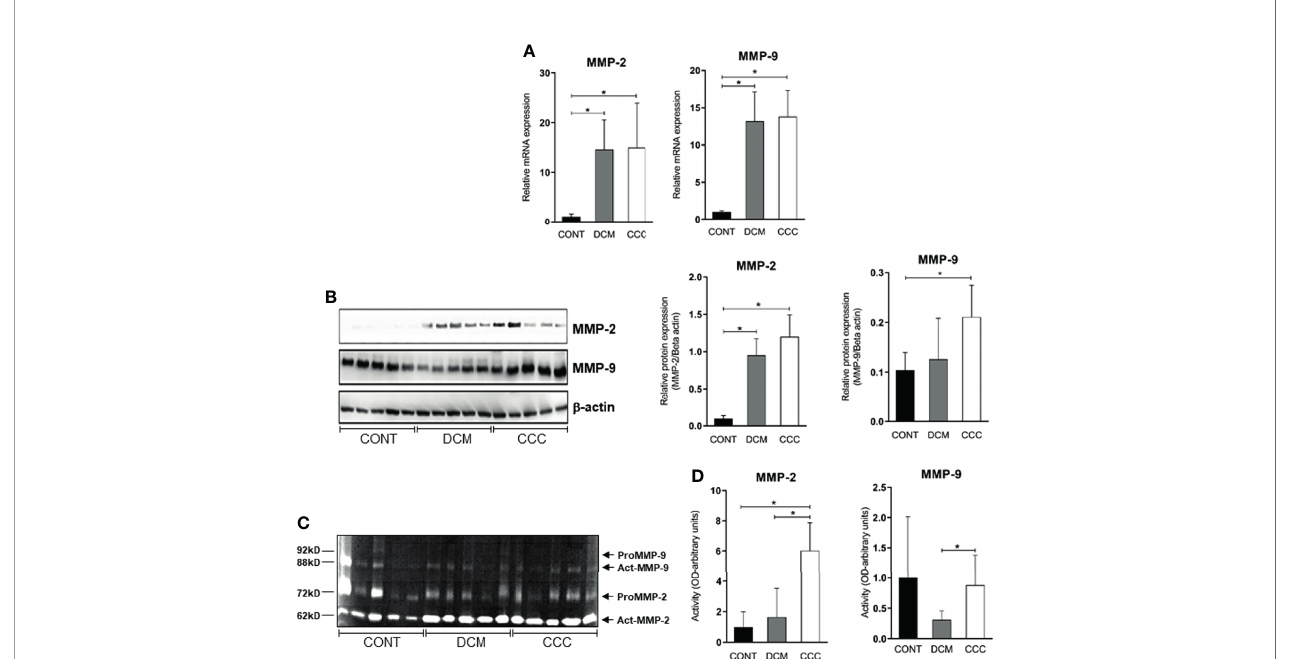
FIGURE 2 | MMP-2 and MMP-9 mRNA and protein expression and activity in myocardium tissue from control, DCM and CCC samples. Myocardial expression of MMP-2 and MMP-9 mRNA. Real-time PCR analysis of mRNA expression in control (n = 6), DCM (n = 12) and CCC (n = 17) myocardium. The expression was calculated as the mean ± SEM for each group as individual data points using the relative expression (fold change over control) by the 2 − DD Ct method, normalized with the endogenous gene RPL0, as described in the Materials and Methods section. (A) Relative expression of MMP-2 mRNA and MMP-9 mRNA. (B) Western blotting image showing protein of MMP-2 and MMP-9 in extracts from myocardium samples from the control, DCM and CCC (n = 5 in each group). The densitometric values of each protein for each sample were normalized by the values of Beta actin, as described in the Materials and Methods section. Densitometry analysis of the MMP-2. Densitometry analysis of the MMP-9. (C) Zimography image showing activity of MMP-2 and MMP-9 in extracts from myocardium samples from control, DCM and CCC (n = 5 in each group). (D) Densitometry analysis of the activated MMP-2 (66 kD band) and activated MMP-9 (88 kD band) results. Groups were compared by a non- parametrical test (Mann – Whitney Rank Sum Test) with GraphPad Prism software (version 6.0; GraphPad). Results were expressed as mean ± SD. *P -values were considered signi fi cant if p-value (0.05) corrected for multiple comparisons by Bonferroni ’ s method (corrected p-value = 0.05/3 = 0.0166). Primary antibodies (with